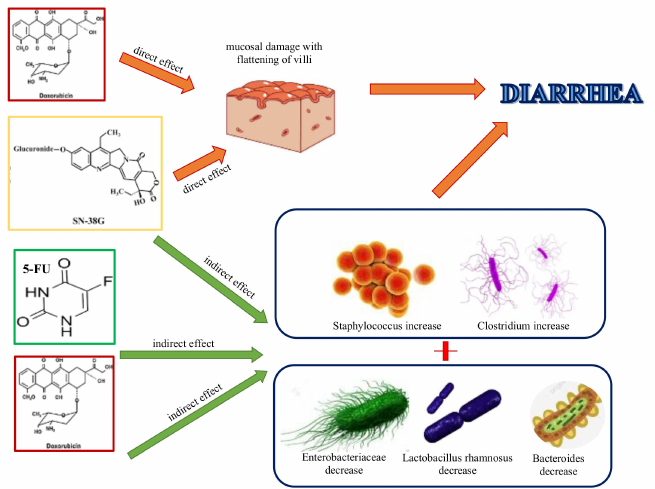
Figure 1. Conventional chemotherapies cause diarrhea by direct damage to the intestinal mucosa, flatteningthevilli(doxorubicinandirinotecan), andalteringgutmicrobiotacomposition,